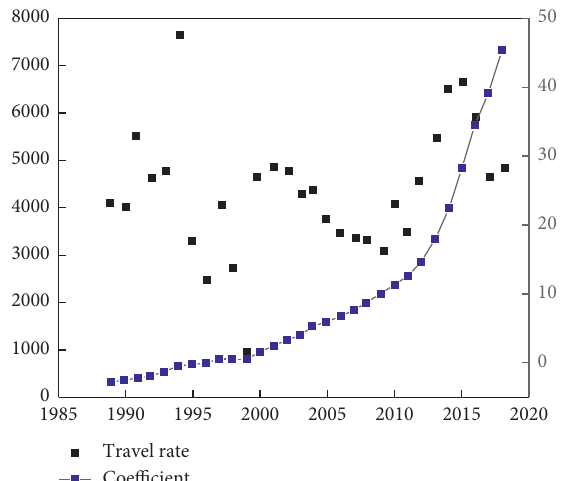
Figure 4: Coefficient and its travel rate trend